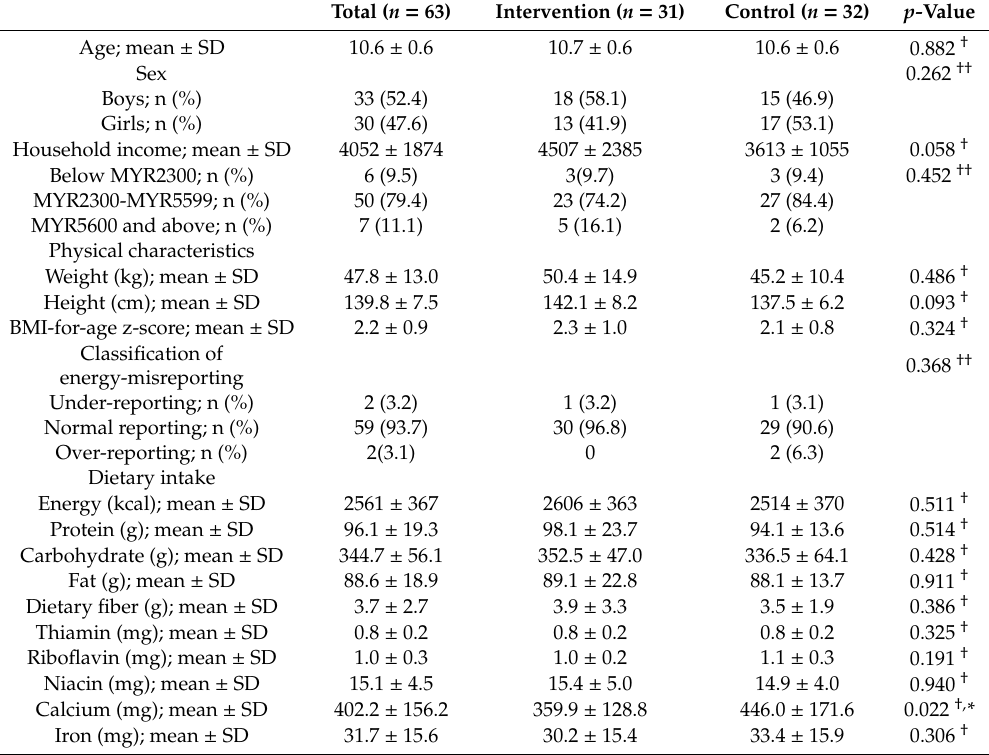
Table 1. Baseline socio-demographics, physical characteristics, under- and over-reporting of energy intake and dietary intakes among children who successfully completed the entire trial ( n =